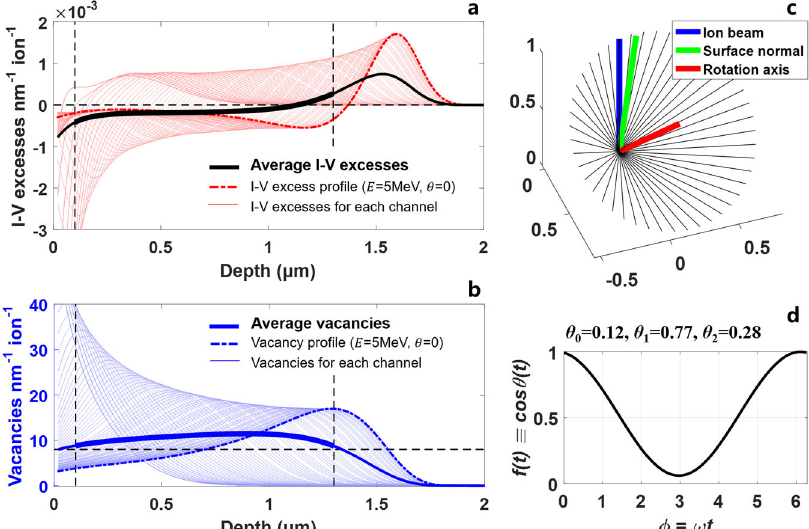
Fig. 5 Minimization of defect imbalance in target material through SSS. The distribution of average I-V excesses a and average damages b with optimized ion momentum mixing, compared with that of ion momentum channels with oblique incidence, as well as the normal incidence. Ion momentum mixing ploted in 3D c and one-linear d forms for the optimized parameters of θ 0 ¼ 0 : 12 ; θ 1 ¼ 0 : 77 ; θ 2 ¼ 0 : 28 ð Þ . Self-ion irradiation in iron with ion energy of 5 MeV and a desired depth window of 0.1 – 1.3 μ m are selected in this case study. Only parts of the ion momentum channels are plotted for clarity in Fig.